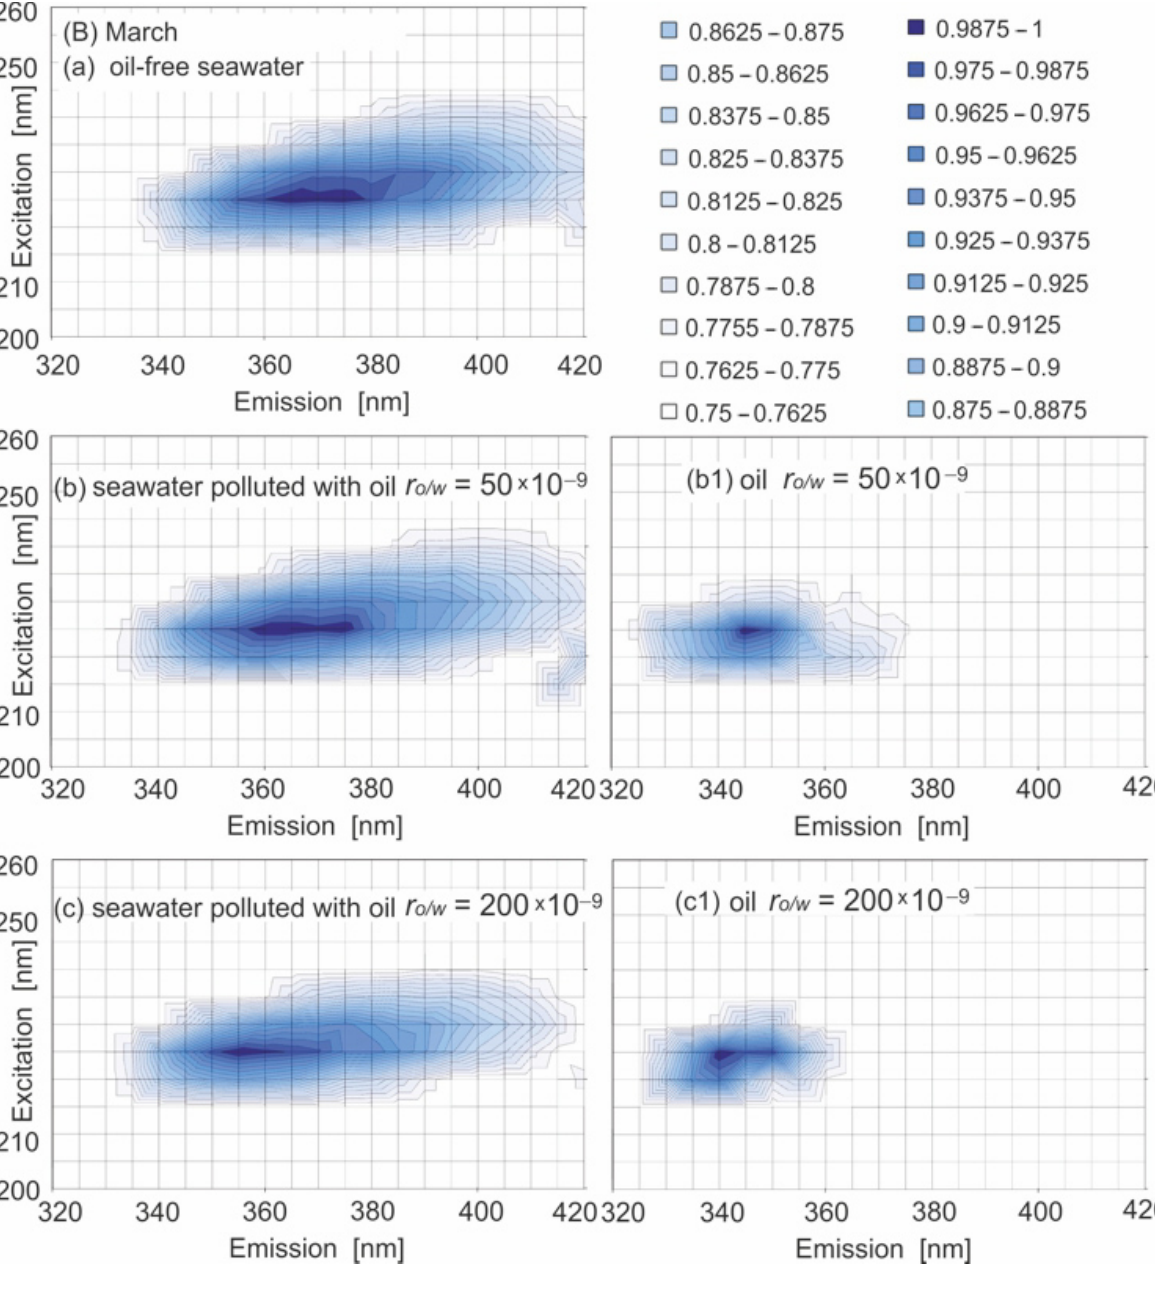
Figure 5. EEMs of oil-free seawater ( a ) and seawater polluted by oil for various r o/w : 50 × 10 –9 ( b ) and 200 × 10 –9 ( c ) and after the removal of the fluorescence of natural components for various r o/w : 50 × 10 –9 ( b1 ) and 200 × 10 –9 ( c1 ), for November ( A ) and March ( B ).